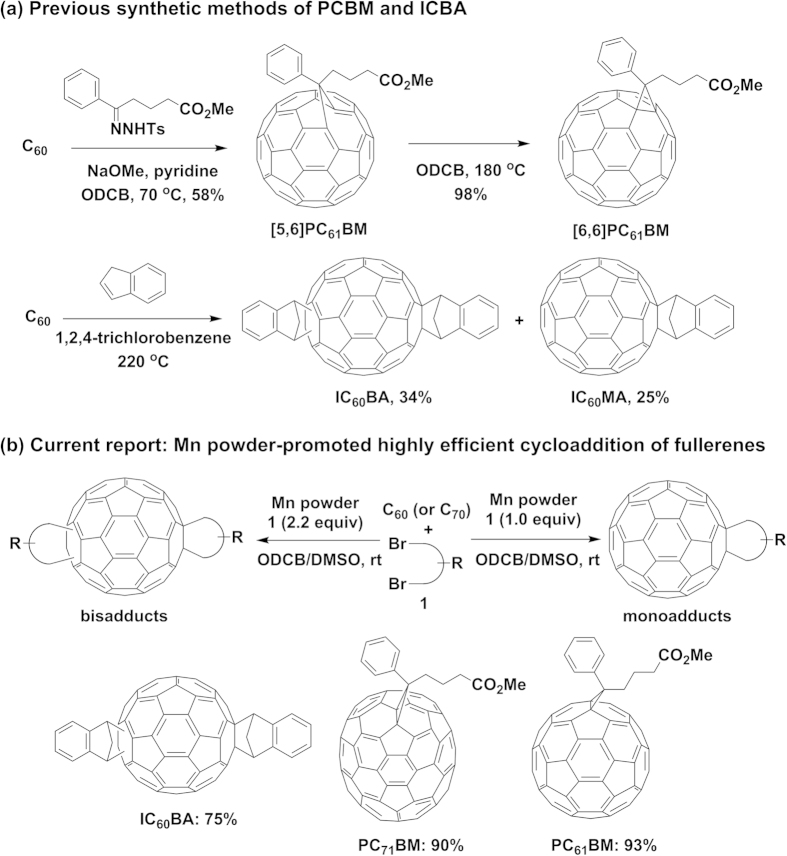
Synthesis of the most common OPV acceptors.(a) The previous synthetic methods for PCBM and ICBA under thermal conditions. (b) Our new method of Mn powder-promoted synthetic method for achieving high yields of mono- and biscycloadducts including PC61BM, PC71BM, and IC60BA.